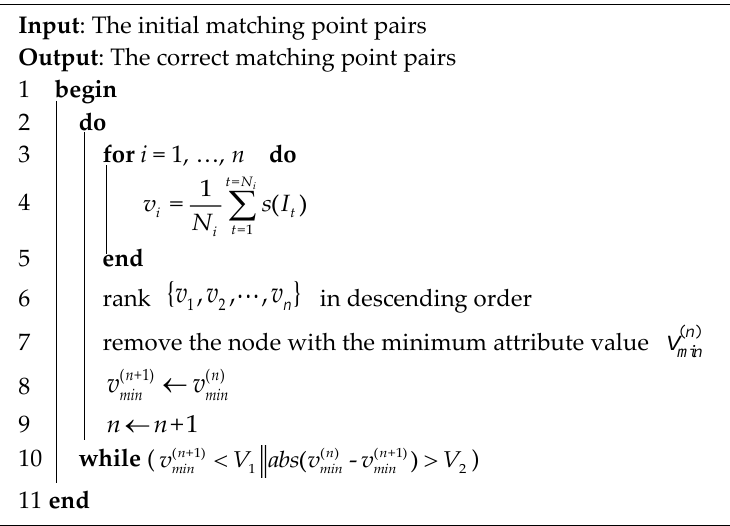
Algorithm 1 : Matching blunder detection by iterating the induced graph